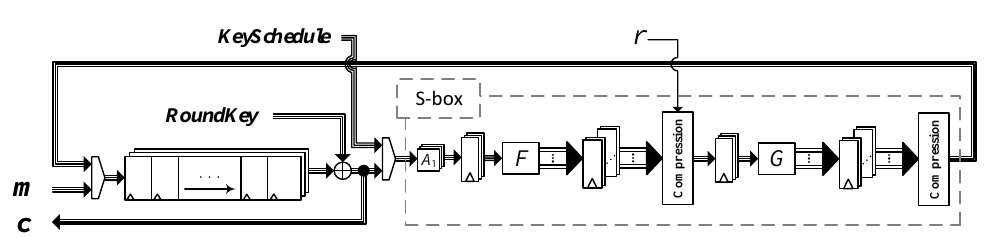
Figure 4: Design architecture of our nibble-serial second-order PRESENT encryption function (permutation layer and key schedule not